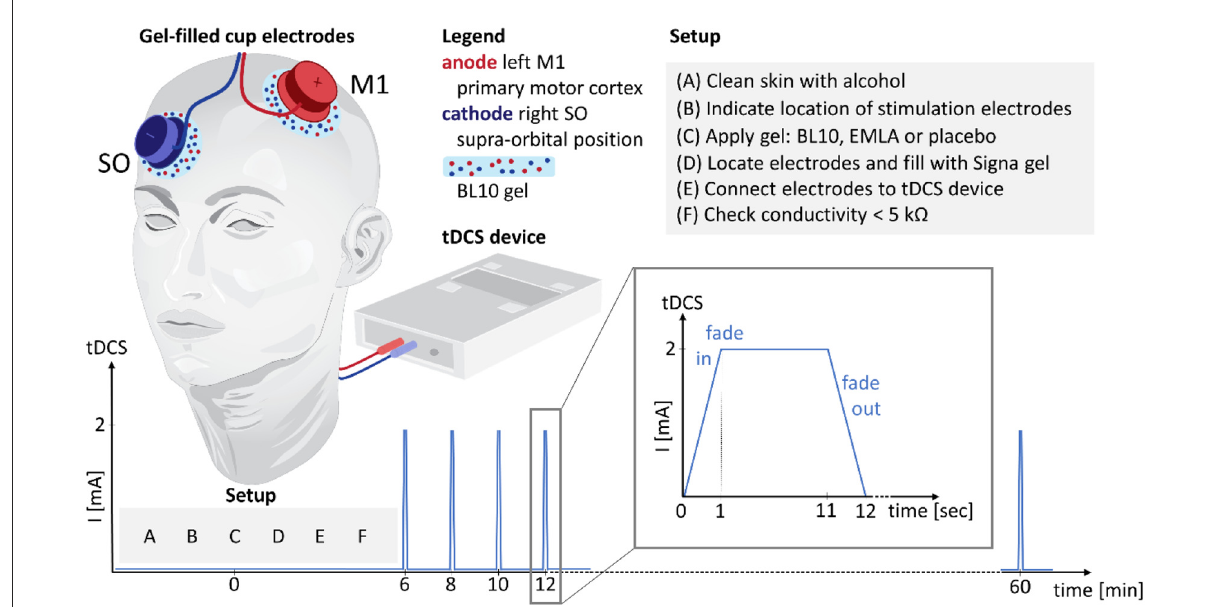
FIGURE2 Protocol. Anodal tDCS was applied over the left primary motor cortex (M1) with the reference electrode in the contralateral supraorbital position. In the setup, the skin was cleaned with alcohol (A), the locations of the stimulation electrodes were indicated on the skin (B), 4.8ml of anesthetic or placebo gel was applied under each electrode (C), the stimulation electrodes were located and filled with Signa gel (D), and connected to the tDCS device (E). A conductivity check was performed (F) to make sure the impedance was below the safety threshold of 5 k (cid:127) . Starting from 6 minutes after gel application, 2mA tDCS was applied for 10s every 2min for a period of 1h. After every stimulus of 10s, subjects assessed the stimulation sensation and reported on potential side effects. In this figure, the setup is illustrated for the BL10